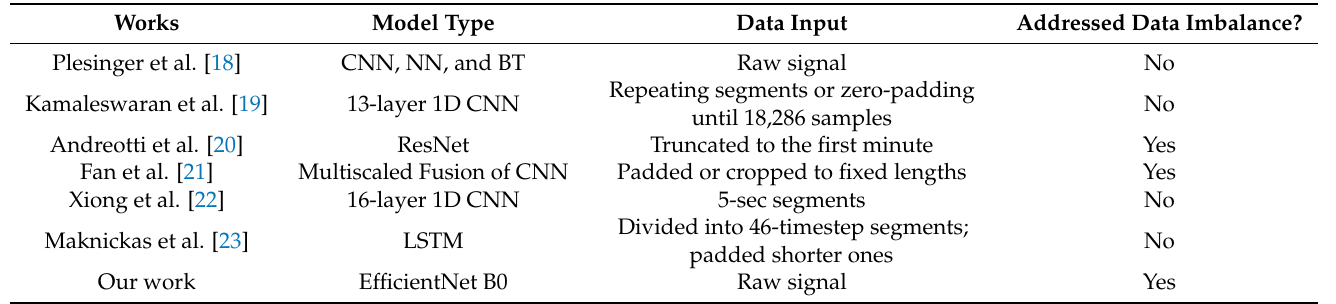
Table 6. Key features of our model in comparison with related works in the literature.